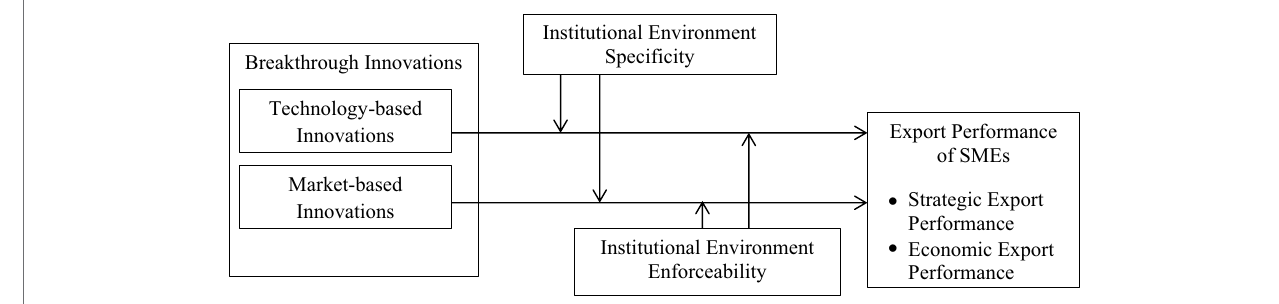
FIGURE 1 | Proposed